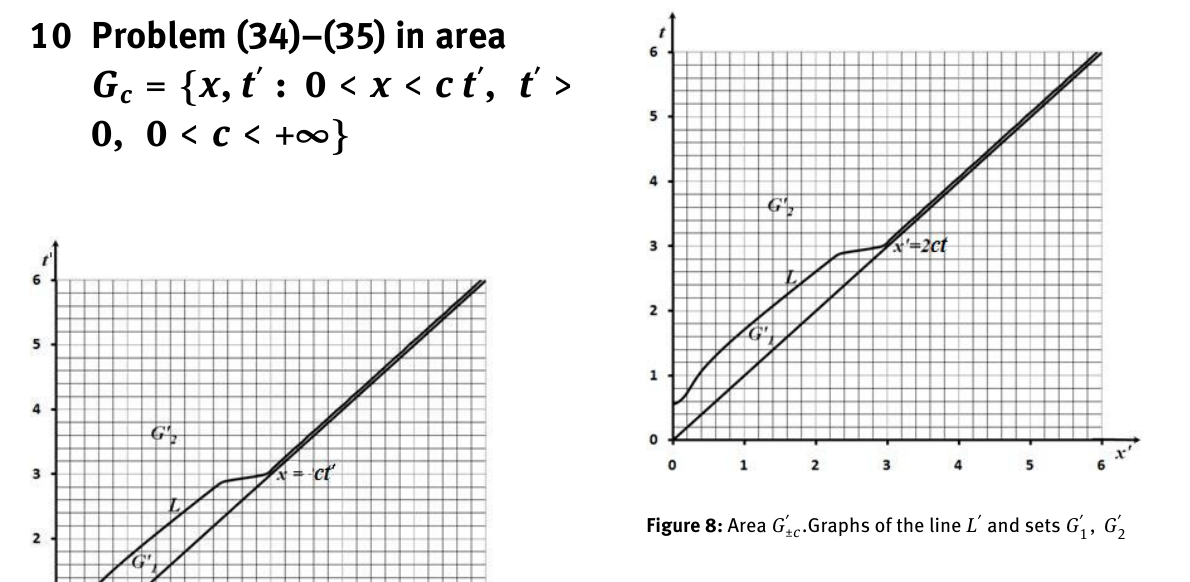
Figure 8: Area G ′ ± c .Graphs of the line L ′ and sets G ′